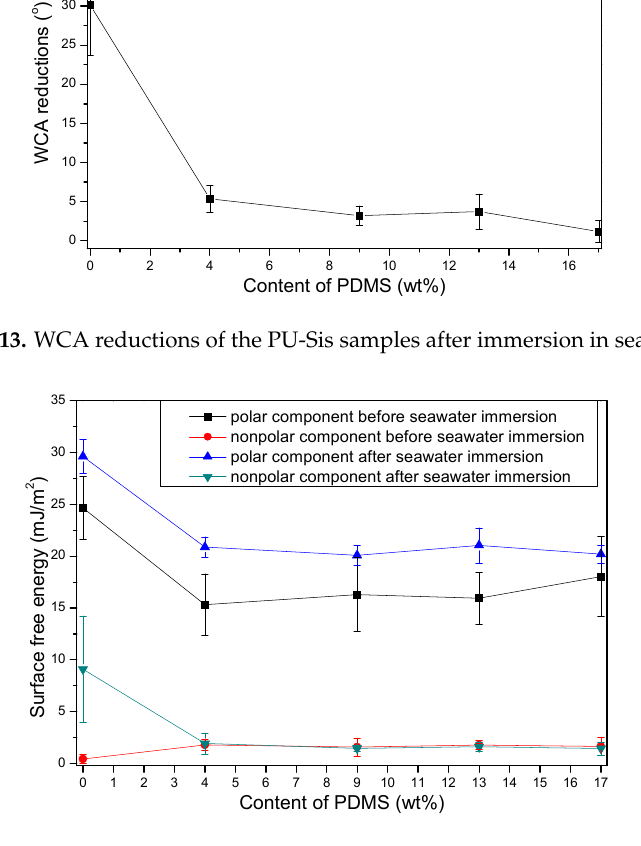
Figure 14. Surface energies of the PU-Sis samples before and after immersion in seawater.